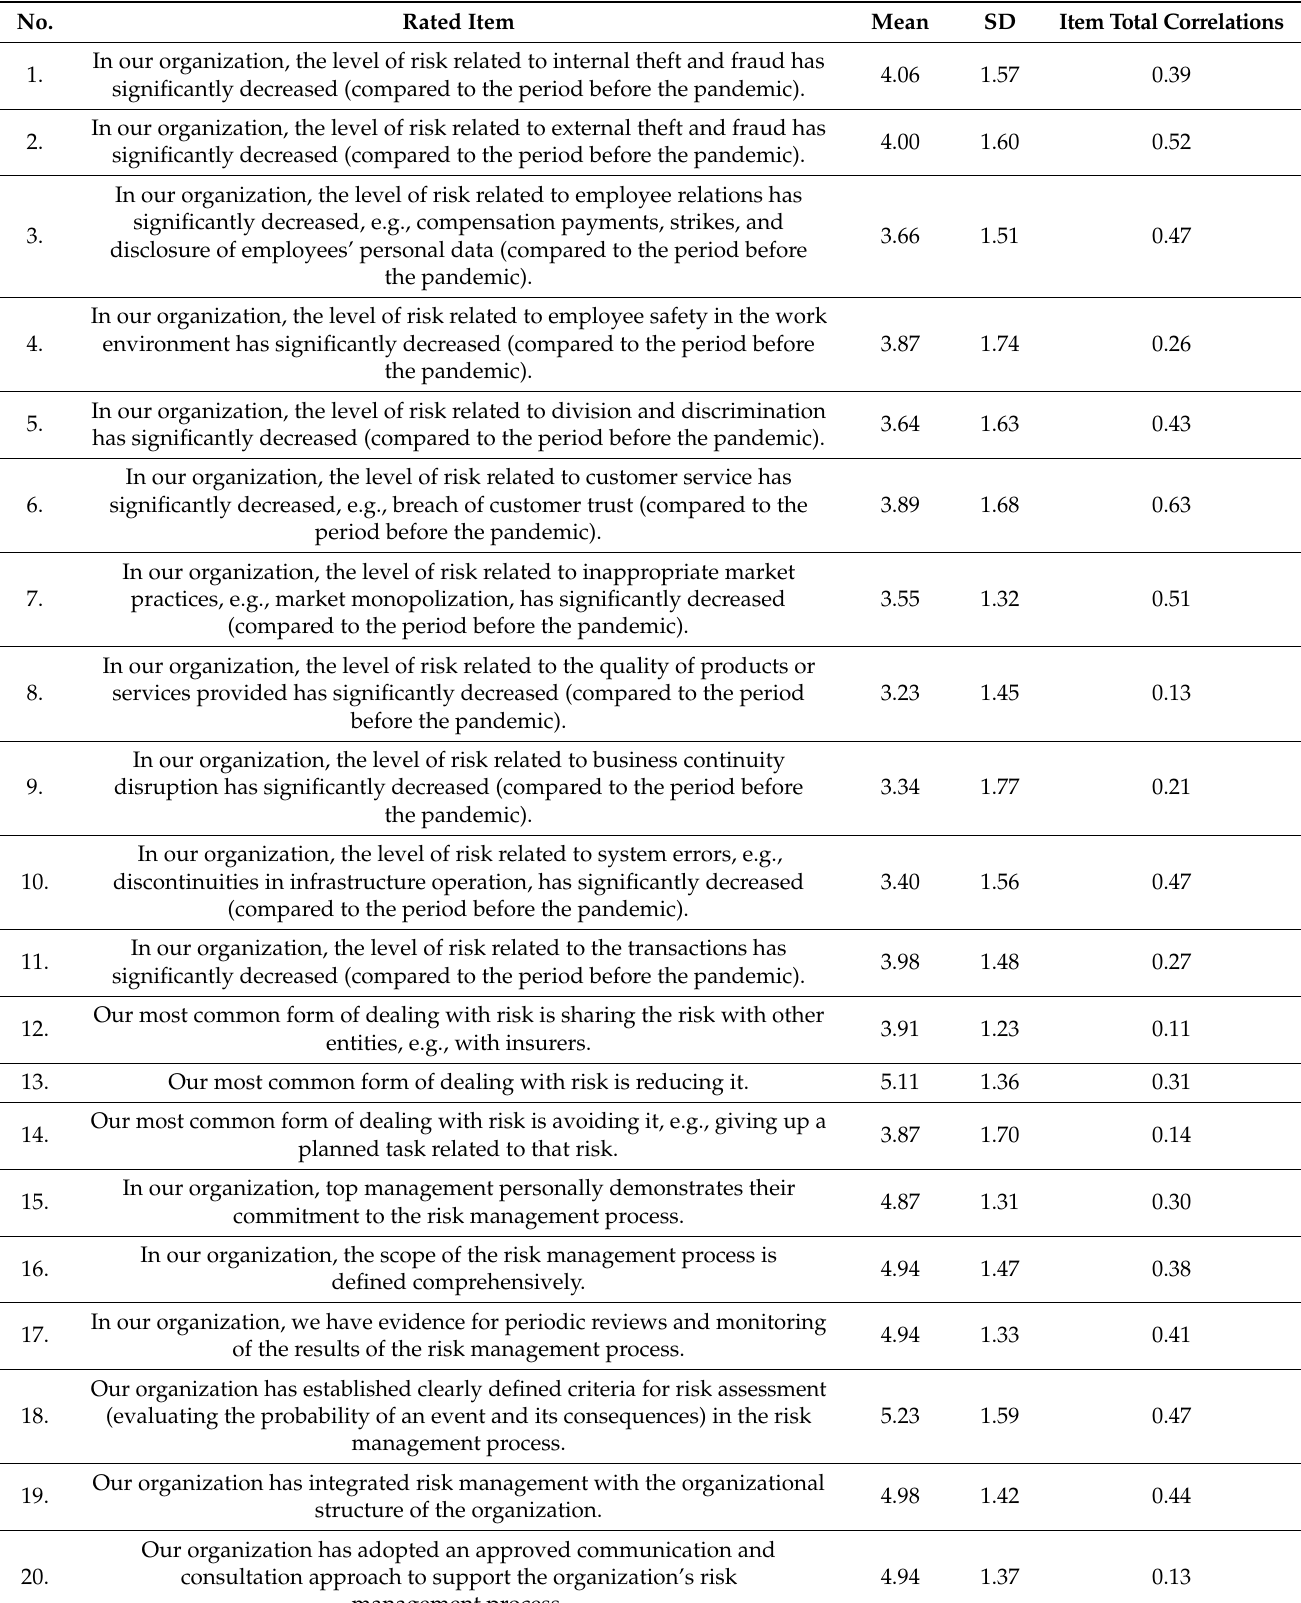
Table 4. Results of the internal consistency